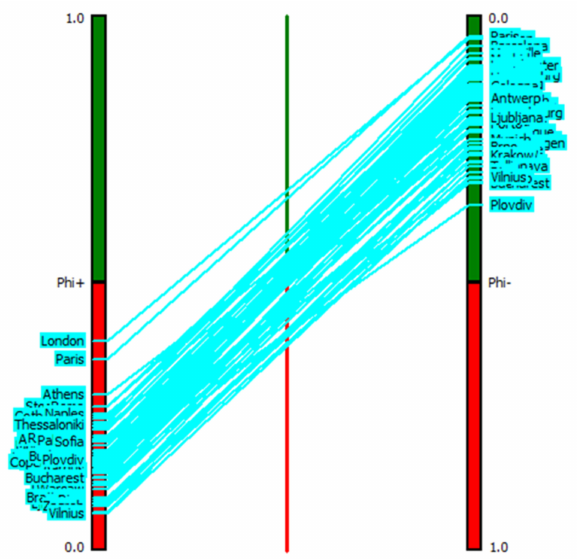
Figure 3. Partial ranking with PROMETHEE